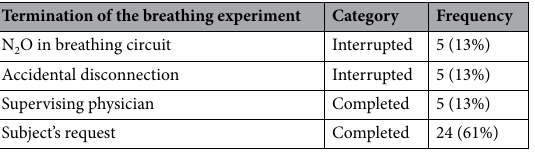
Table 3. Reasons for termination of the breathing experiments and their